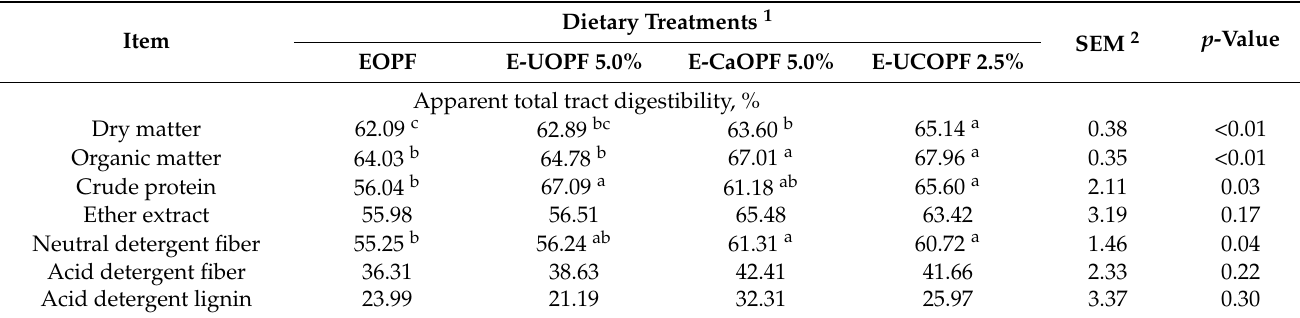
Table 4. Effect of ensiled oil palm fronds supplemented with urea-calcium hydroxide on the apparent total tract digestibility of